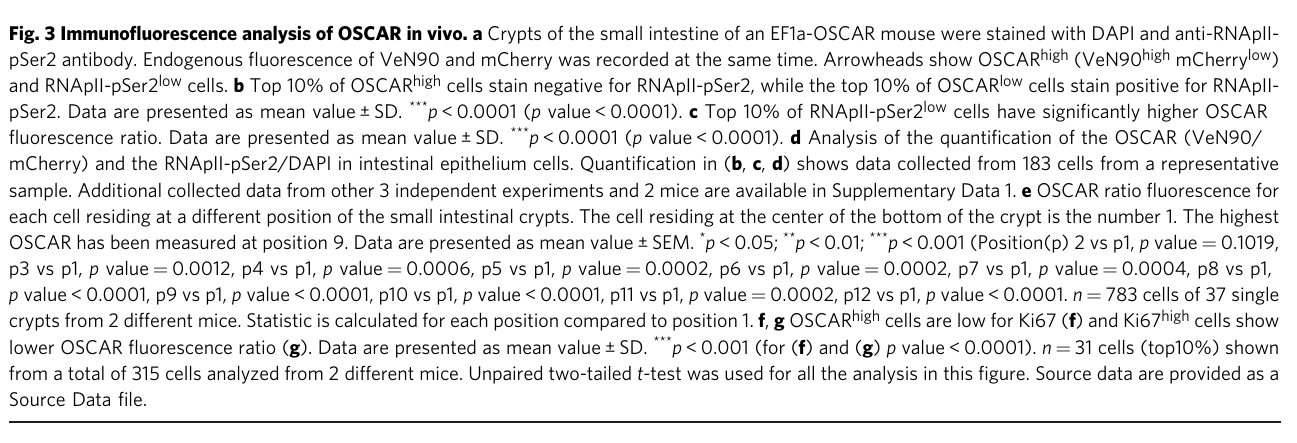
Fig. 3 Immuno fl uorescence analysis of OSCAR in vivo. a Crypts of the small intestine of an EF1a-OSCAR mouse were stained with DAPI and anti-RNApII- pSer2 antibody. Endogenous fl uorescence of VeN90 and mCherry was recorded at the same time. Arrowheads show OSCAR high (VeN90 high mCherry low ) and RNApII-pSer2 low cells. b Top 10% of OSCAR high cells stain negative for RNApII-pSer2, while the top 10% of OSCAR low cells stain positive for RNApII- pSer2. Data are presented as mean value ± SD. *** p < 0.0001 ( p value < 0.0001). c Top 10% of RNApII-pSer2 low cells have signi fi cantly higher OSCAR fl uorescence ratio. Data are presented as mean value ± SD. *** p < 0.0001 ( p value < 0.0001). d Analysis of the quanti fi cation of the OSCAR (VeN90/ mCherry) and the RNApII-pSer2/DAPI in intestinal epithelium cells. Quanti fi cation in ( b , c , d ) shows data collected from 183 cells from a representative sample. Additional collected data from other 3 independent experiments and 2 mice are available in Supplementary Data 1. e OSCAR ratio fl uorescence for each cell residing at a different position of the small intestinal crypts. The cell residing at the center of the bottom of the crypt is the number 1. The highest OSCAR has been measured at position 9. Data are presented as mean value ± SEM. * p < 0.05; ** p < 0.01; *** p < 0.001 (Position(p) 2 vs p1, p value = 0.1019, p3 vs p1, p value = 0.0012, p4 vs p1, p value = 0.0006, p5 vs p1, p value = 0.0002, p6 vs p1, p value = 0.0002, p7 vs p1, p value = 0.0004, p8 vs p1, p value < 0.0001, p9 vs p1, p value < 0.0001, p10 vs p1, p value < 0.0001, p11 vs p1, p value = 0.0002, p12 vs p1, p value < 0.0001. n = 783 cells of 37